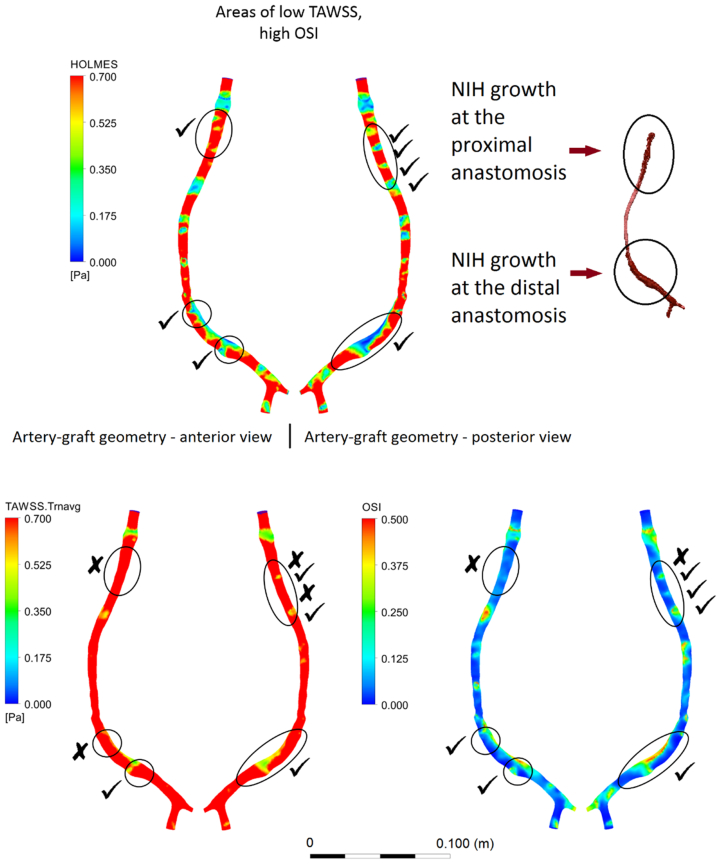
Example of contour plots of hemodynamic indices obtained for patient 3. A, Simulation for highly oscillatory, low magnitude shear (HOLMES). B, Simulation for time-averaged wall shear stress (TAWSS). C, Simulation for oscillatory shear index (OSI). The tick marks refer to areas of neointimal hyperplasia (NIH) actually captured by computational fluid dynamics (CFD) simulations. TAWSS and HOLMES are considered to have low values when <0.5 Pa (the non-red areas in the contour plots). It can be seen that in the case of TAWSS and OSI, many remodeled regions are not indicated (identified by x).